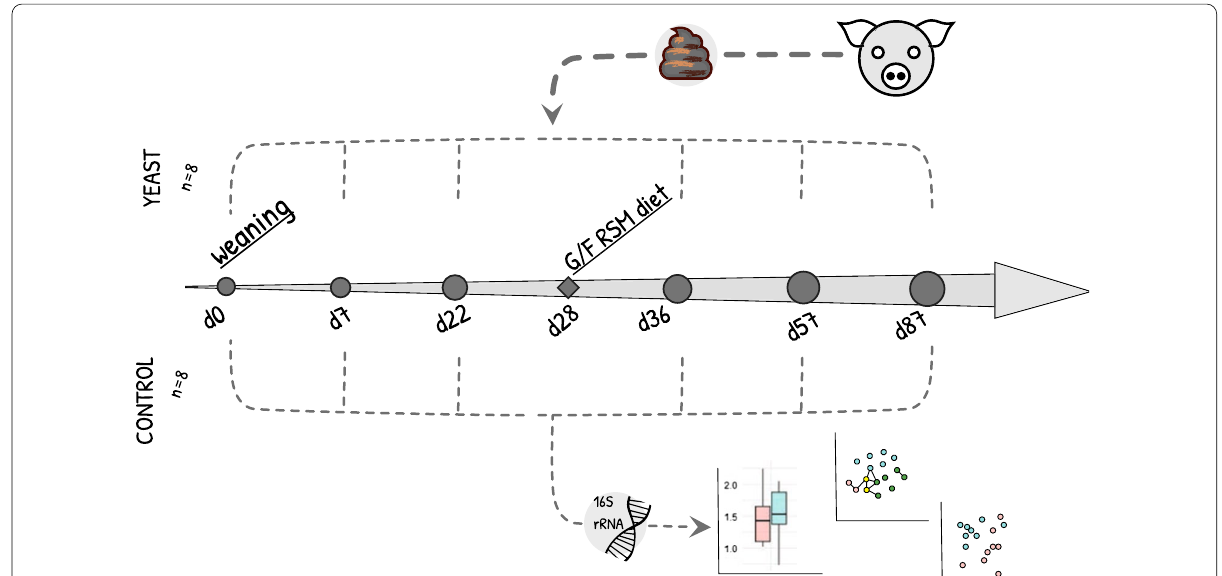
Fig. 1 Overview of the experimental design. The timeline of the experiment is shown for two groups of animals in the experiment: YEAST (“YL” in the text) and CONTROL (“CL” in the text). Metabarcoding sequencing was done for the faecal samples collected at the days drawn as grey circles (d0, d8, d22, d36, d57, and d87